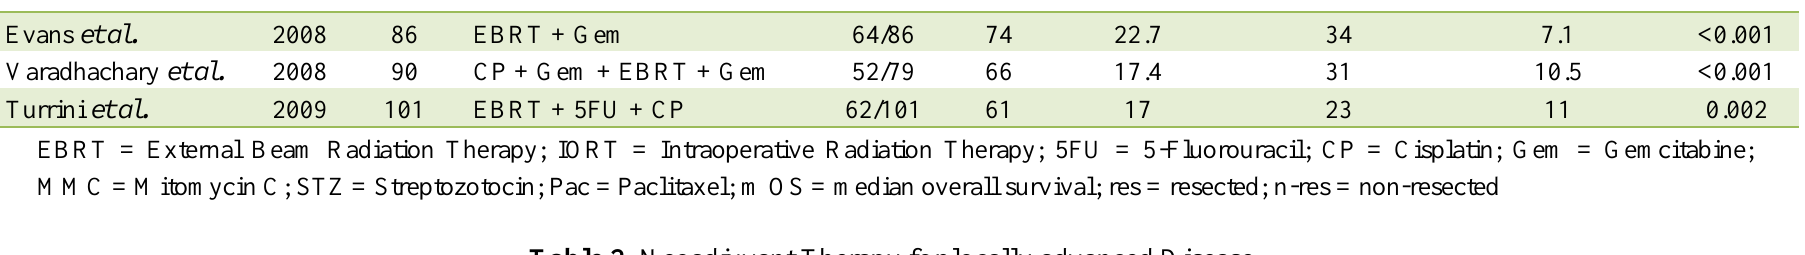
Table 2. Neoadjuvant Therapy for locally advanced